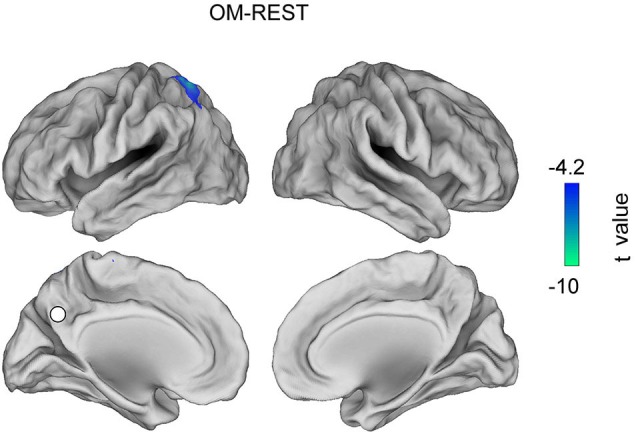
T map for the contrast OM meditation vs. REST obtained in the alpha band (p < 0.01, FDR corrected value).